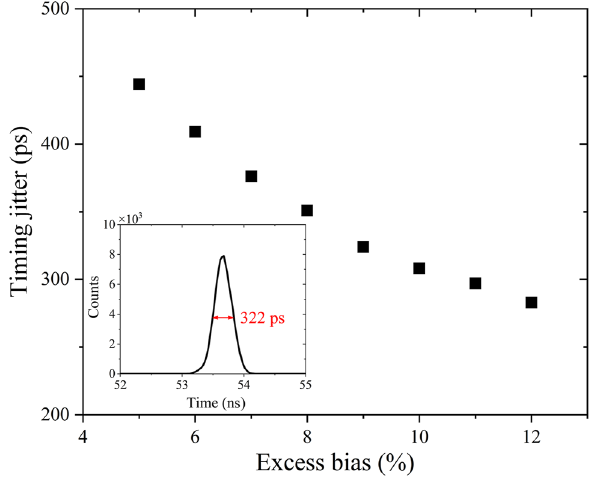
Figure 8: The measured system timing jitter as a function of excess bias = 1 V. The inset shows the time histogram for the lowest jitter at V S1 obtained at 12% excess